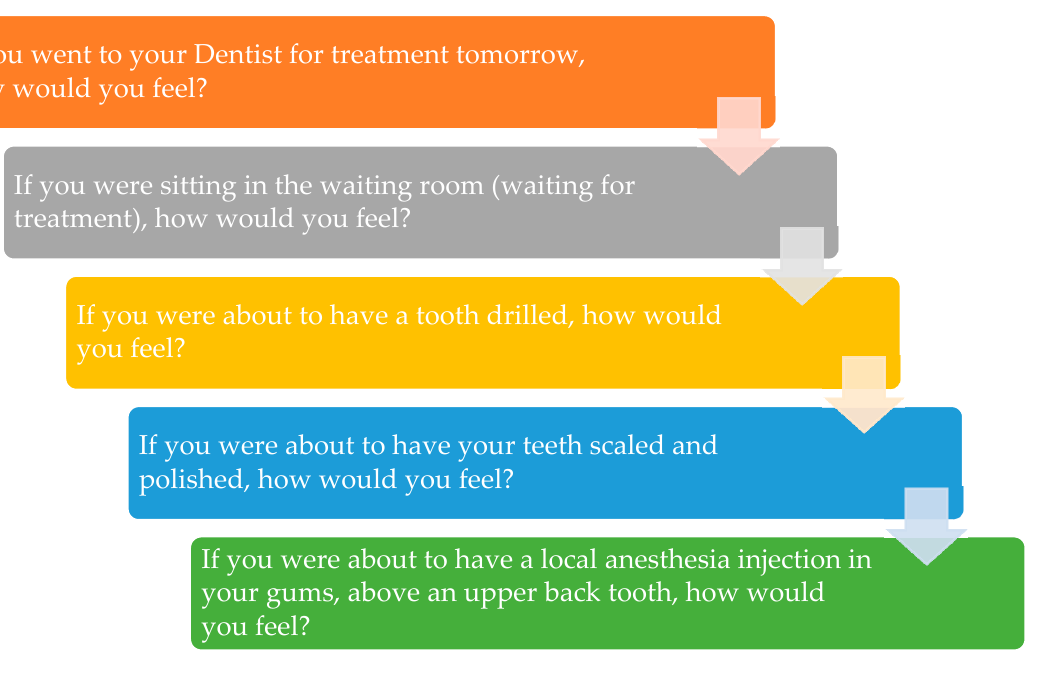
Figure 1. Modified dental anxiety scale.